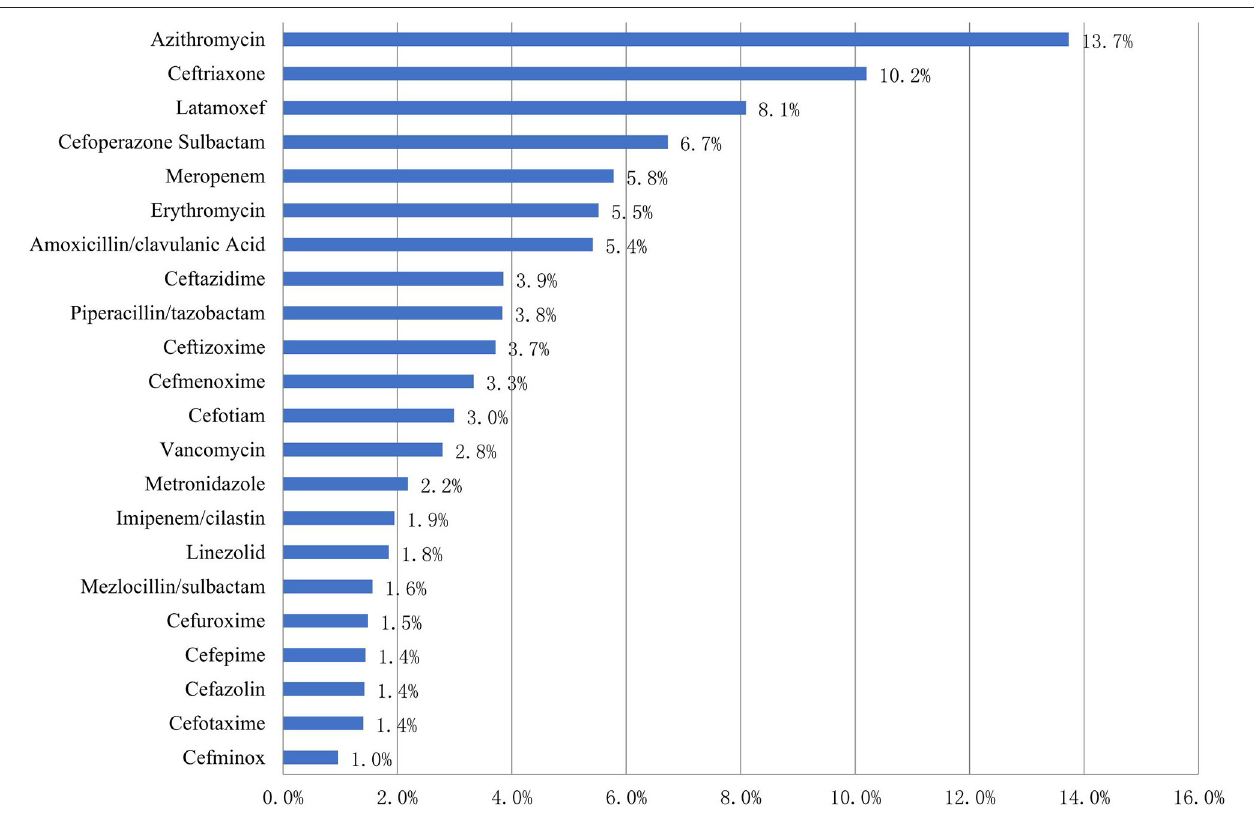
FIGURE 1 | Patterns of antibiotic prescribing to Chinese children by drug utilization 90% in 2017–2019 (%).